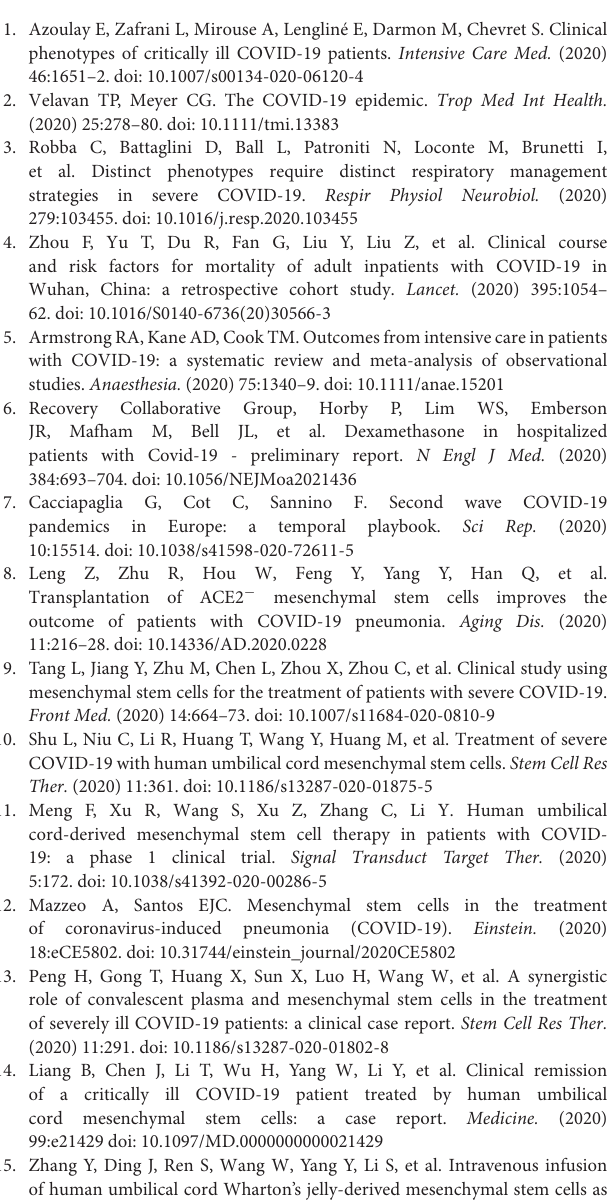
cells (C) , monocyte subtype based on CD14 and CD16 expression (D) , CX1CR3 (E) , CCR2 (F) , CCR7 (G) , CCR6 (H) , and CCR5 (I) expression. Supplementary Figure 4 | Gating strategy display the analysis of T lymphocytes in regard to memory phenotype and function. Peripheral Blood mononuclear cells (PBMCs) were stained using the panel indicated in the method section for quantitative analysis of memory and function markers in both CD4 + and CD8 + T cells. Samples were gated on monocytes based on SSC-A (complexity) and FSC-A (size) (A) , single events (B) , CD3 + CD45 + cells (T lymphocytes) (C) , CD4 and CD8 T cells (D) , CXCR3 and CCR6 (T helper subtype) (E) , and CD45 and CD27 (memory markers) (F) . Supplementary Table 1 | List of antibodies used for the flow cytometry